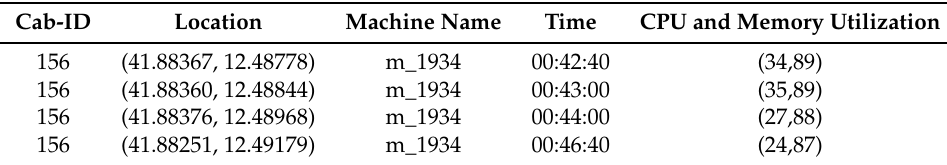
Table 2. A sample of the data set in the onsecutive time-based